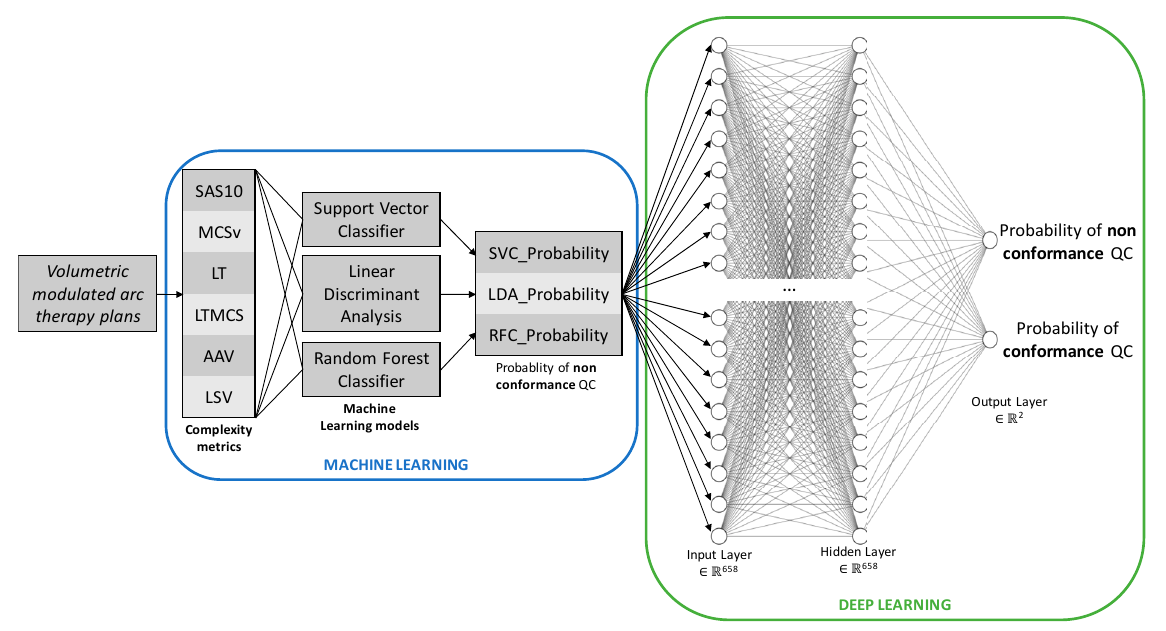
Figure 2. Deep hybrid learning model architecture (breast tumor location example).